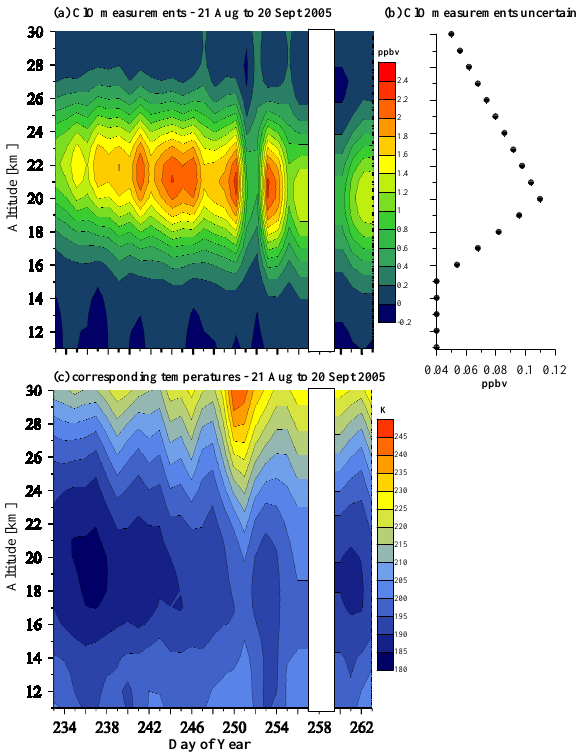
Fig. 1. Measured ClO concentrations in ppbv (panel a ), the cor- responding errors (panel b ) and the coincident temperatures in K (panel c ) plotted as a function of altitude and day of the year in 2005. The blue and organge/red colours in panel (a) depict low ClO concentrations (below 0.2ppbv) and high ClO concentrations (above 1.6ppbv), respectively. In panel (c) , low temperatures (be- low 210K) are indicated by the blue colour range, while high tem- peratures (above 225K) are shown in the yellow to red colour